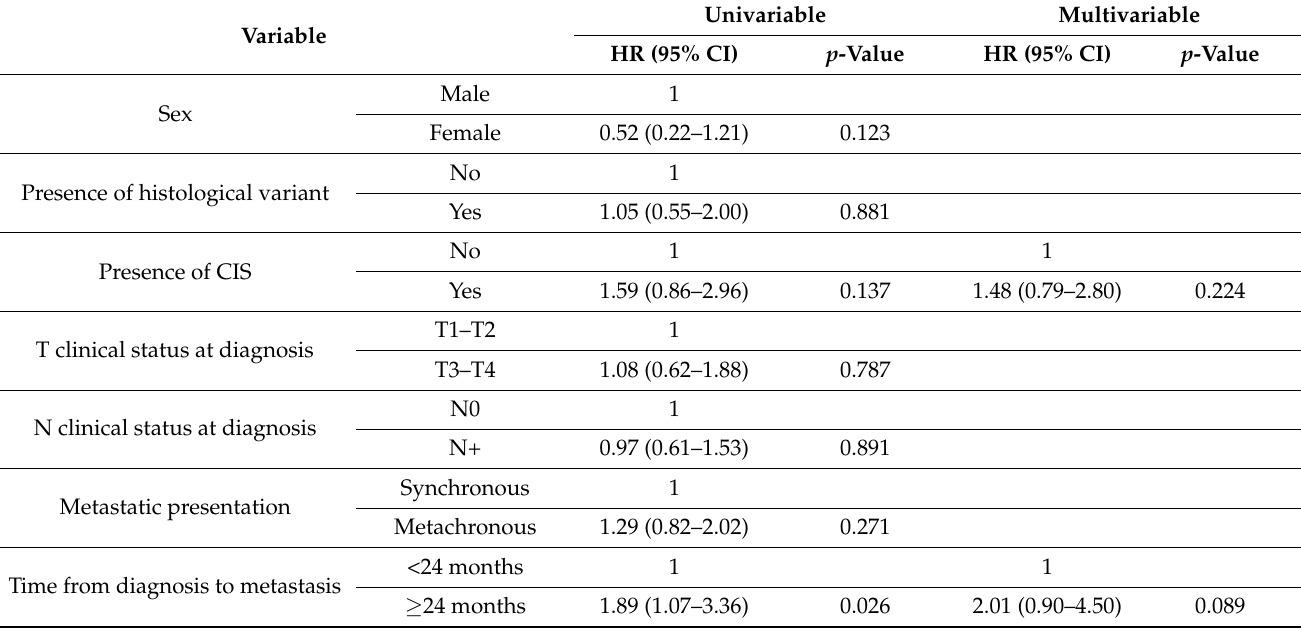
Table 3. Univariable and multivariable analysis for progression-free survival (landmark population analysis at 6